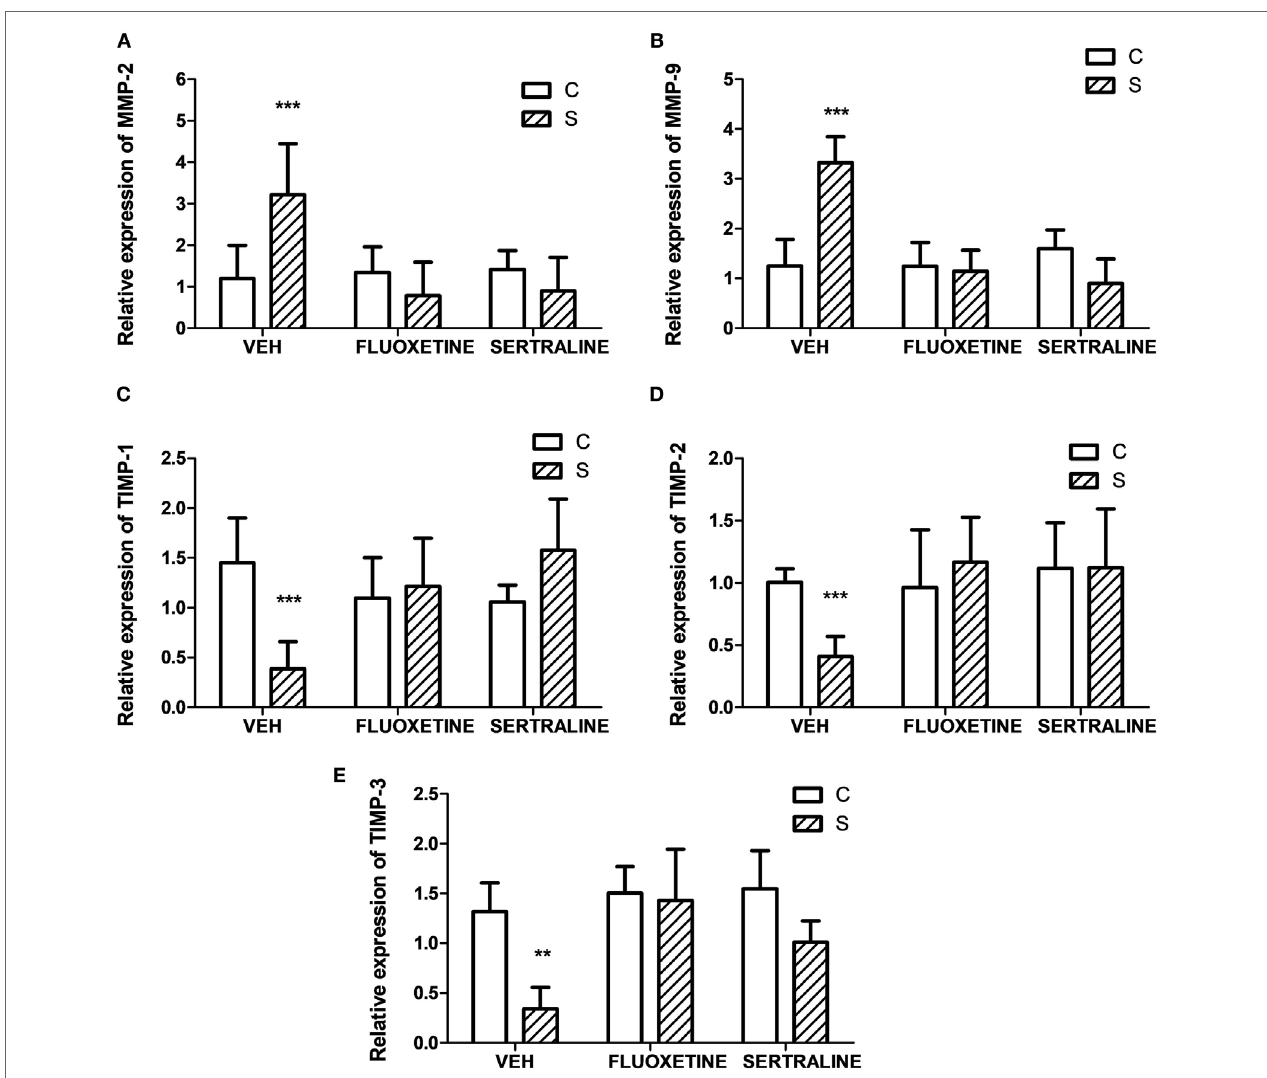
FigUre 7 | Effect of chronic stress on the expression of proteins associated with cell invasion. Action of fluoxetine and sertraline. Quantitative real-time reverse transcription polymerase chain reaction was performed in cDNA obtained from solid tumors excised 14 days post EL4 cells inoculation. (a) MMP-2, (B) MMP-9 and their inhibitors (c) TIMP-1, (D) TIMP-2, and (e) TIMP-3 mRNA relative expression was quantified using β 2 -microglobulin as housekeeper. Values are expressed as mean ± SEM. n = 6 mice per group. ** p < 0.01; *** p < 0.001 respect to control